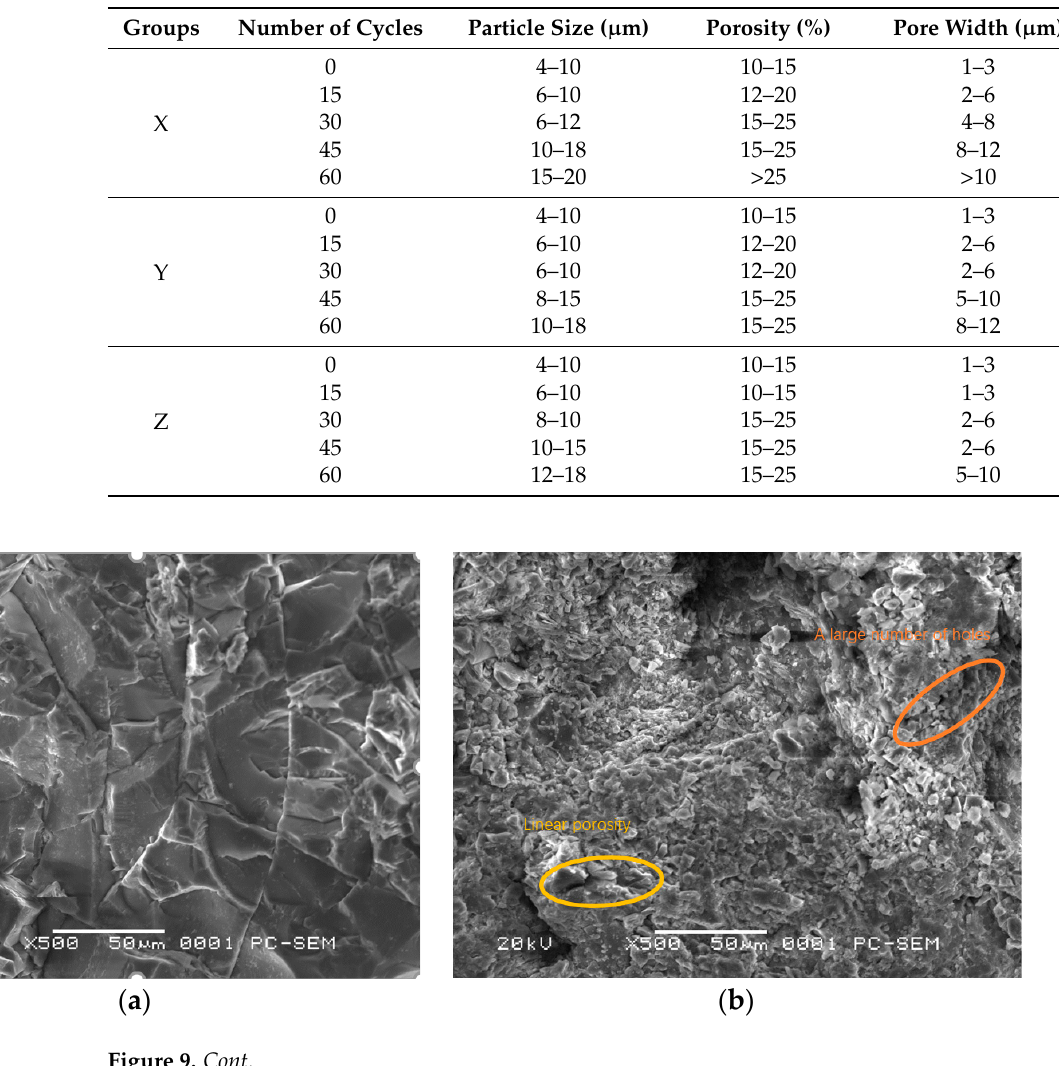
( f ) ( g ) Figure 9. SEM photographs of rock after 60 F–T cycles for three treatments: ( a ) untreated samples (500×); ( b ) snowmelt (500×); ( c ) rain infiltration (500×); ( d ) normal F–T (500×); ( e ) corrosion of feld- spar (1000×); ( f ) corrosion of calcite (1000×); and ( g ) increase in clay (1000×).